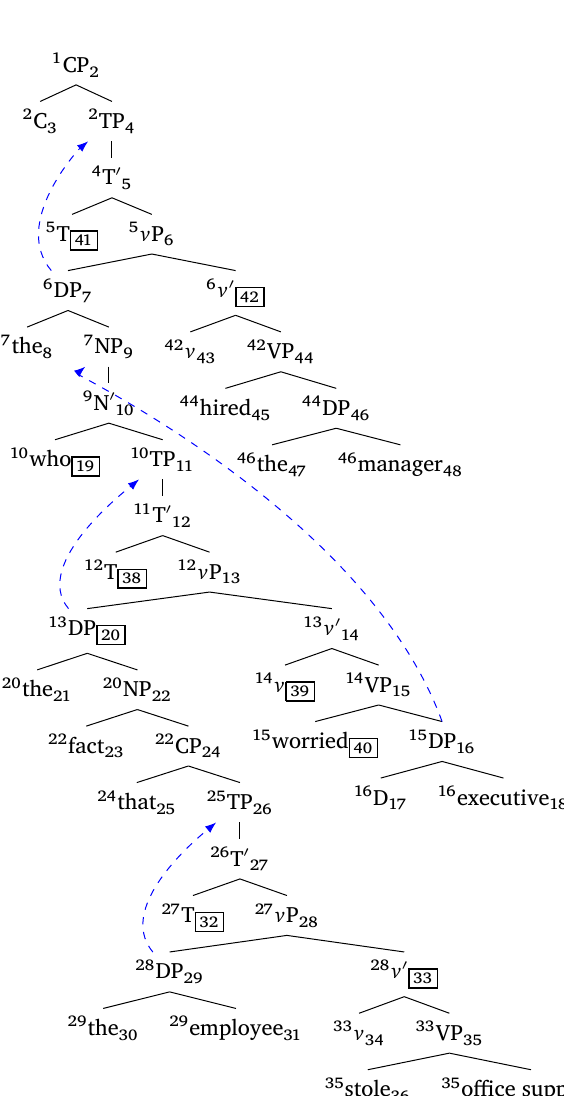
Figure 10: ORC containing a sentential complement, promotion